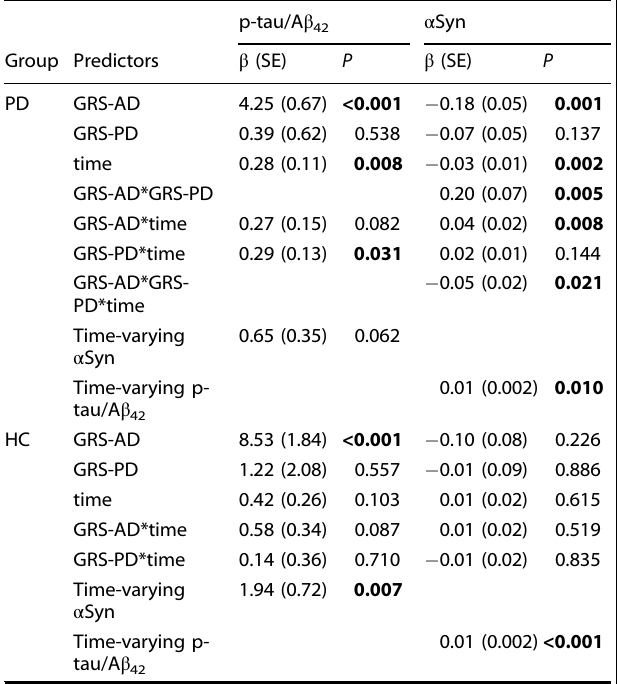
Table 3. Association between genetic risk scores and longitudinal CSF biomarkers in PD patients and